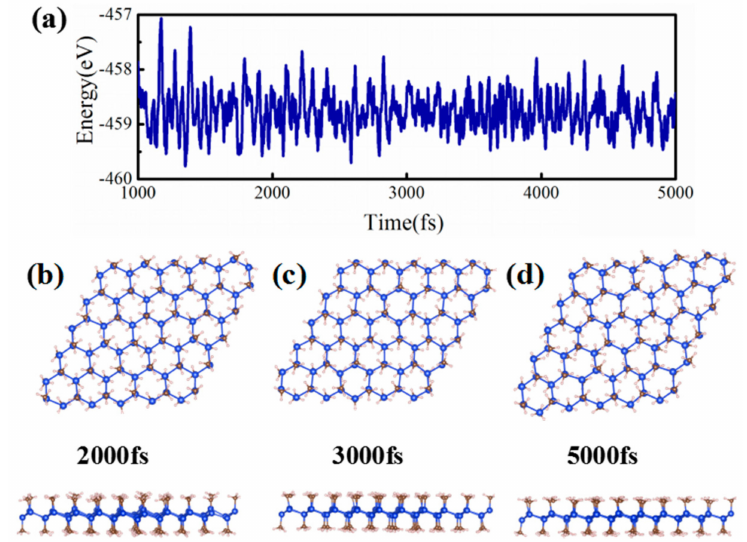
Figure 2. ( a ) Variations of the free energy from 2000 to 5000 fs, during ab initio molecular dynamics simulations (AIMD) at the temperature of 300 K for SiCH 3 ; ( b – d ) indicated the snapshot of molecular dynamics (MD)simulation of the structure in 2000, 3000, and 5000 fs,